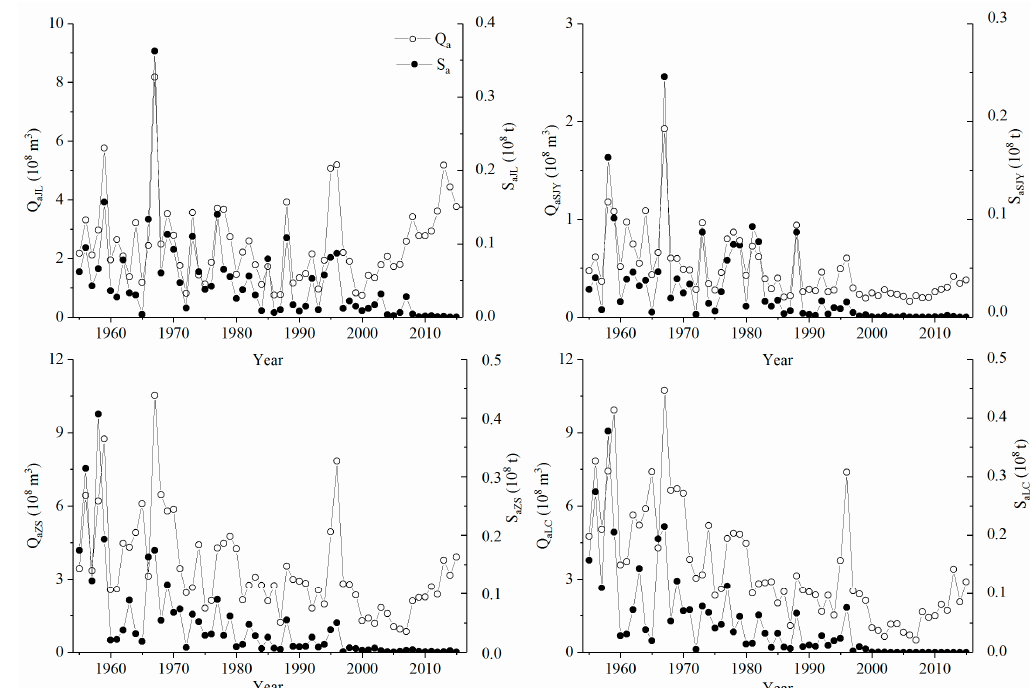
Figure 2. Temporal variation in Q a and S a values for four hydrological stations from 1955 to 2015. JL: Jingle, ZS: Zhaishang, LC: Lancun, SJY: Shangjingyou. Table 2. Q a and S a trends revealed by the Mann − Kendall tests.